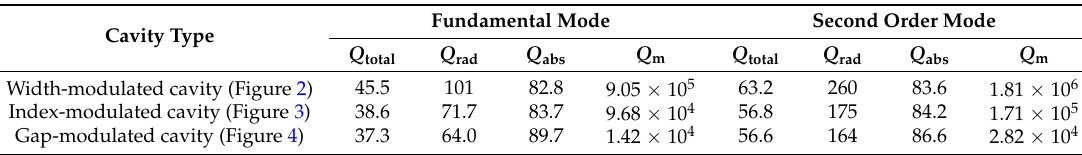
Table 1. Quality factors of the three